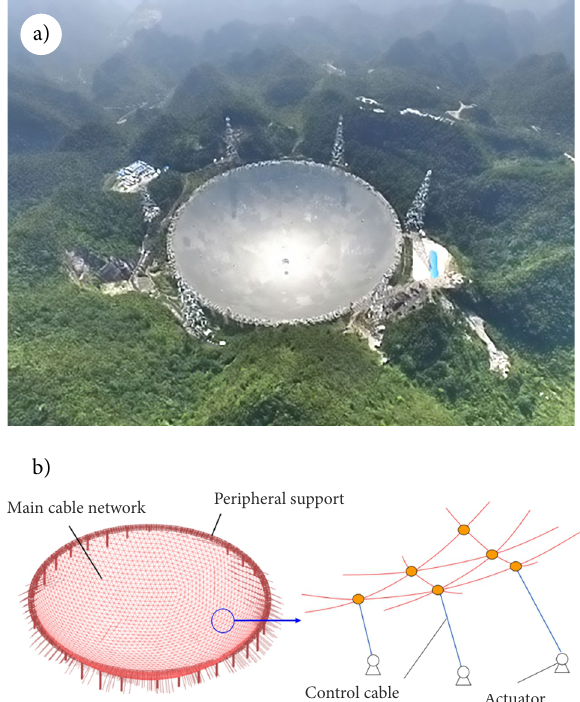
Figure 1. The complex cable-net structure of the FAST active reflector: a – Real image; b – Numerical model